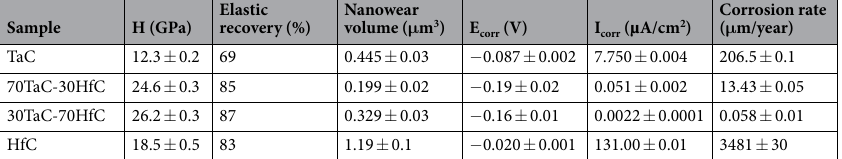
Table 2. Hardness, elastic recovery, nanowear and corrosion properties (E corr = corrosion potential and I corr = corrosion current) of the